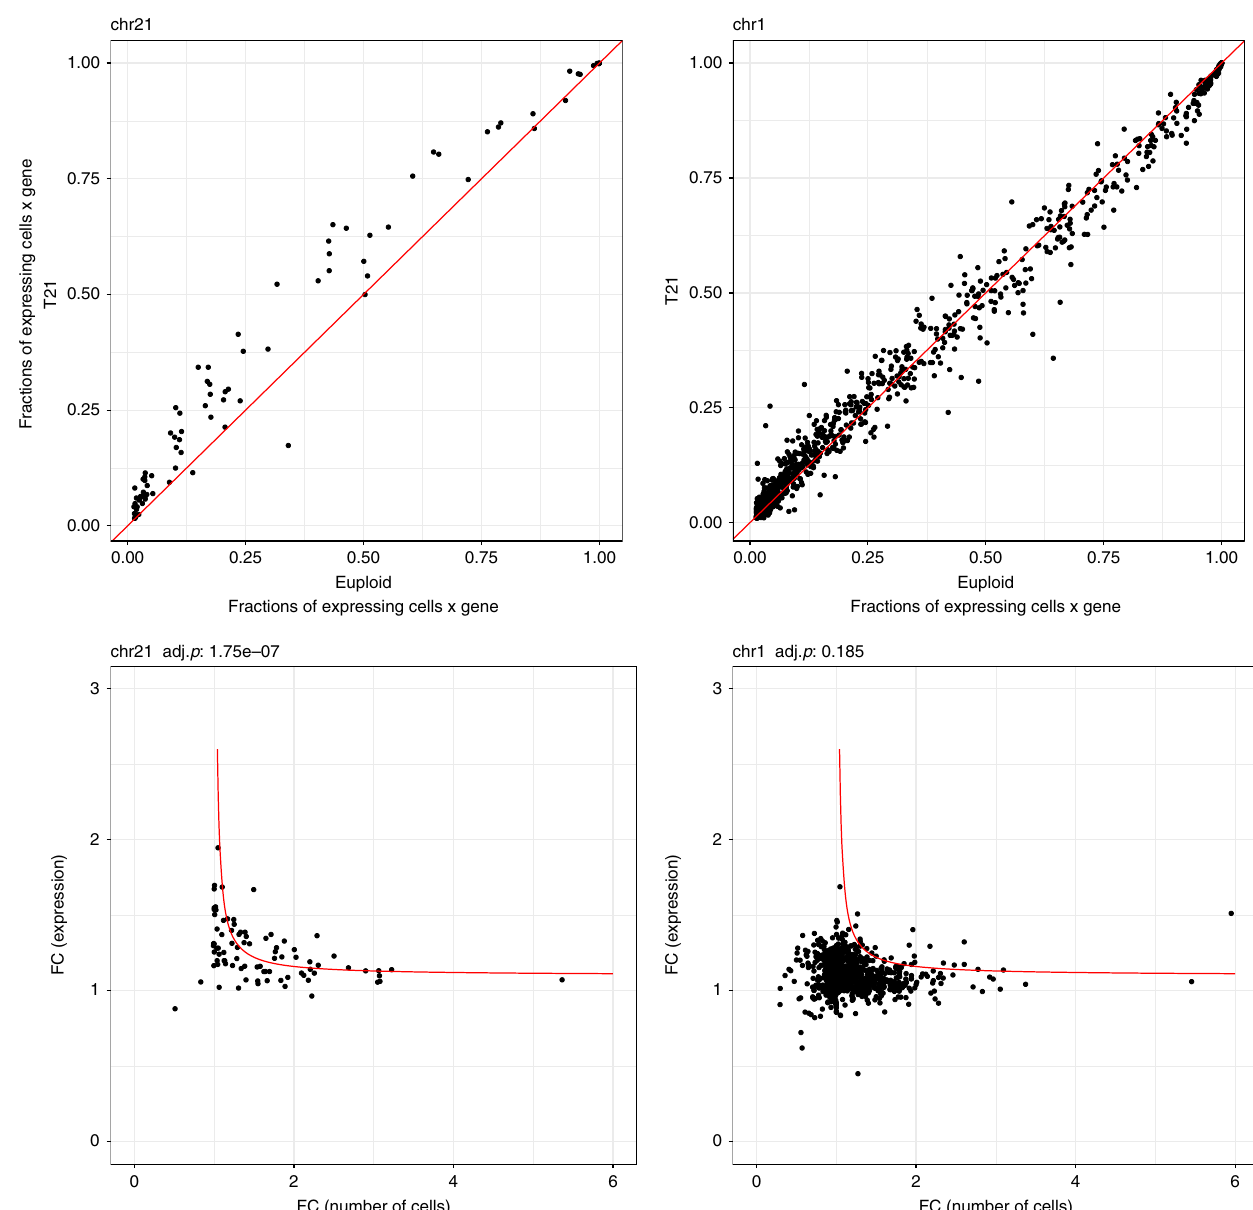
Fig. 7 Higher fraction of expressing cells of trisomic genes in 8740 single fi broblasts. Upper row, left: ( y -axis) distribution of fraction of trisomic cells expressing chr21 genes; ( x -axis) distribution of fraction of diploid single cells expressing chr21 genes; right: data for chr1 as control. Lower row, left: T/D ratio of number of expressing cells and T/D ratio of single-cell expression of genes in chr21 are inversely correlated (Spearman correlation); right: data for chr1 as control. Cells with >5 reads and genes expressed in >50 cells have been considered. Red line is to guide the eye (see text for details). Source data are provided in the public